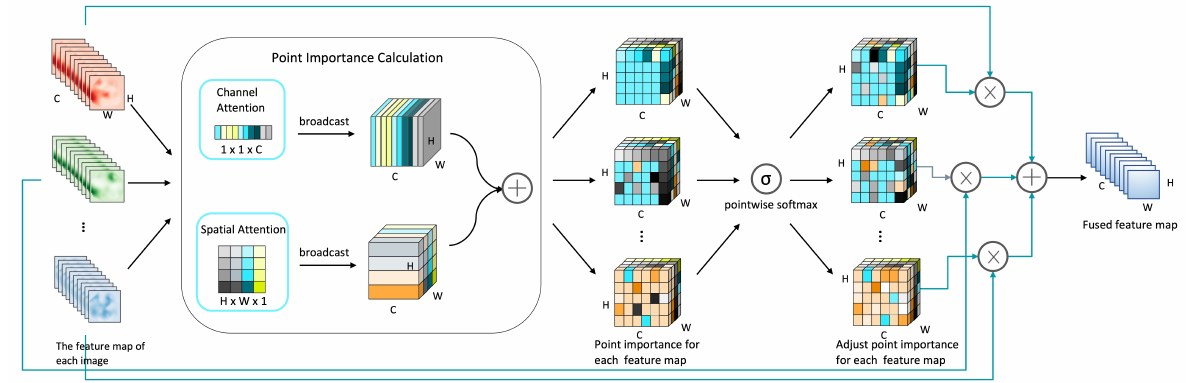
Figure 3. The illustration of the feature map fusion module. It fuses the feature map of each image into a fused feature map based on the attention